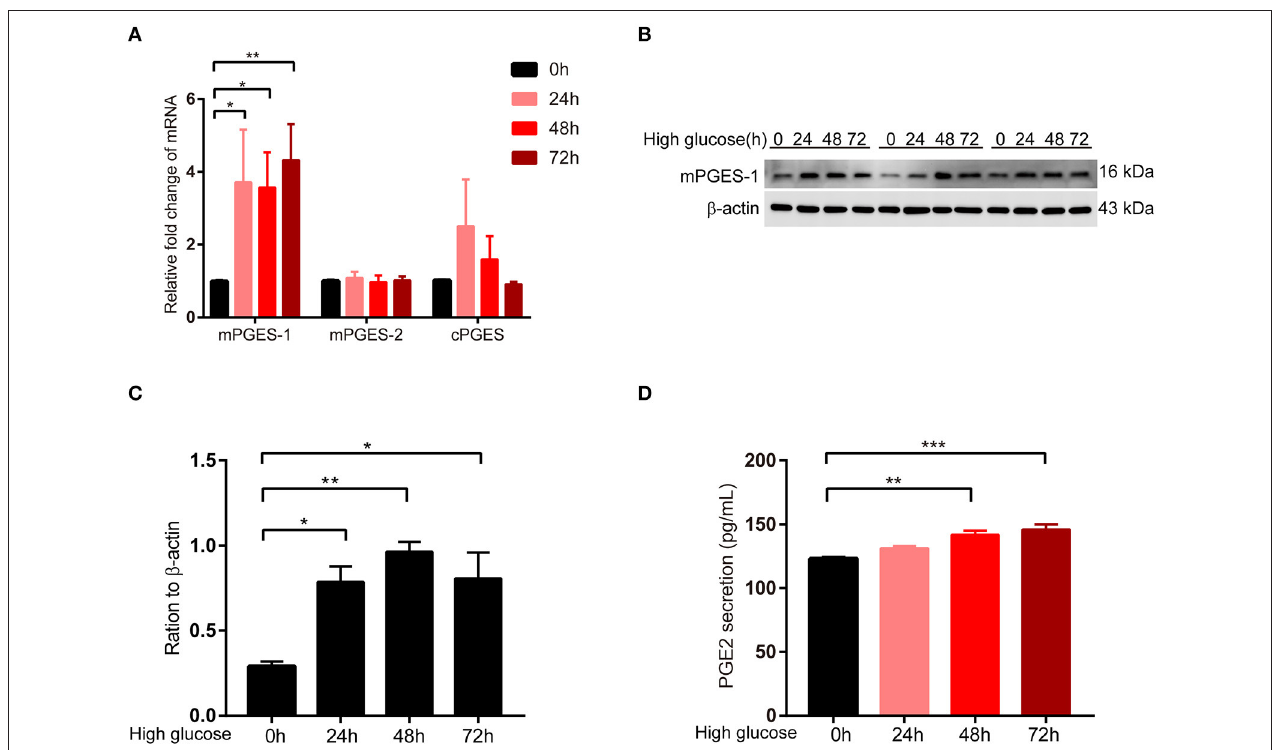
FIGURE 3 | Induction of mPGES-1 expression by high glucose in RPMCs. (A) Real-time quantitative PCR analysis of mPGES-1, mPGES-2, and cPGES levels in RPMCs in response to high glucose (138 mmol/L) for the indicated times. (B) RPMCs were incubated with high glucose (138 mmol/L) for the indicated times, and western blotting detected the expression of mPGES-1. (C) Quantitative analysis of mPGES-1 expression in RPMCs treated with high glucose (138 mmol/L) for the indicated times. (D) RPMCs were treated with high glucose (138 mmol/L) for the indicated times, and ELISA was performed for PGE2 in the cell culture medium. The data are represented as the mean ± SEM. * P < 0.05, ** P < 0.01, and *** P < 0.001.